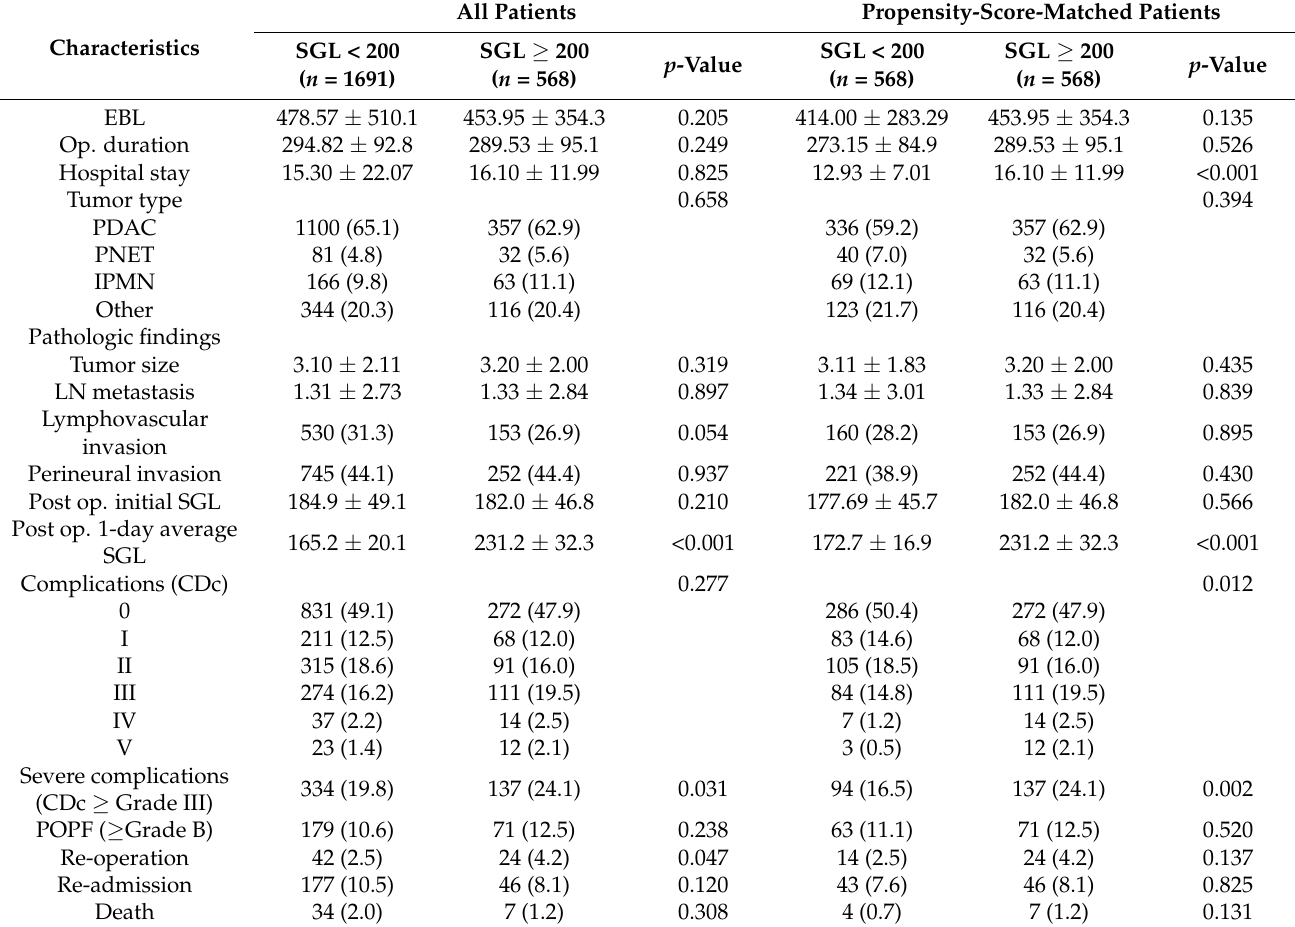
Table 2. Postoperative